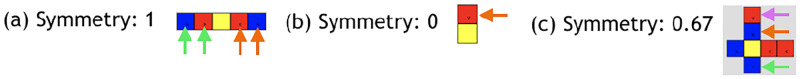
Morphology (a) has the modules indicated by green arrows horizontally reflected by the modules indicated by orange arrows; (b) has no modules reflected; (c) has the module indicated by the orange arrow vertically reflected by the modules indicated by the green arrow, but no reflection for the module indicated by the pink arrow.